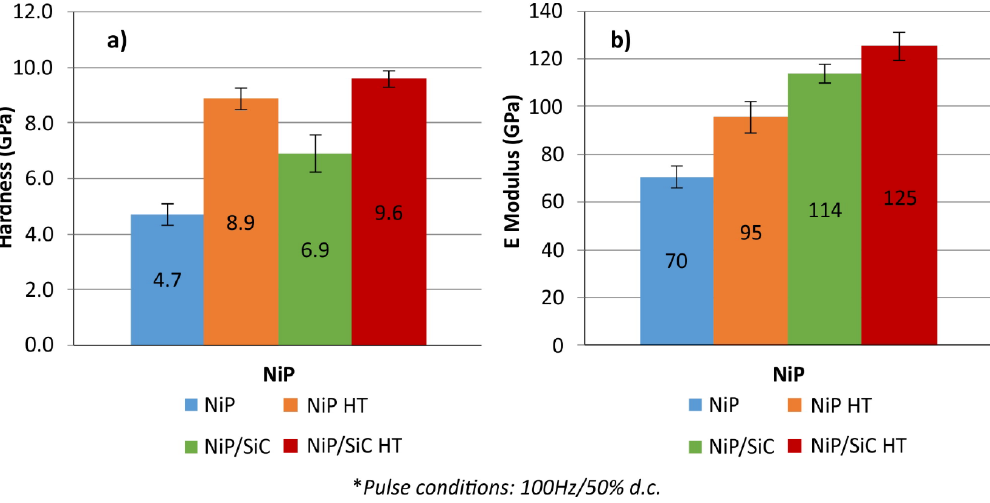
Figure 8. Calculated ( a ) hardness and ( b ) elastic modulus of as-plated Ni-P, Ni-P/SiC nanocomposites, and the heat treated coatings.